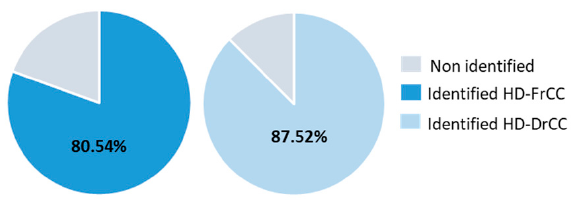
Figure 3. Diagram showing the portion of identified compounds in the hydrodistillate of C. cornic- ulata . HD-FrCC—hydrodistillate of fresh C. corniculata ; HD-DrCC—hydrodistillate of air-dried C. corniculata .